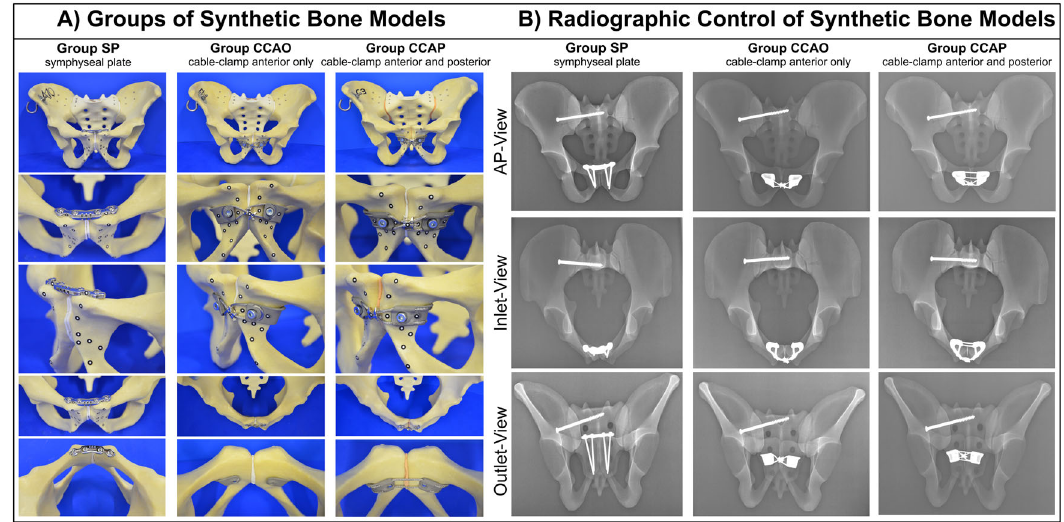
Fig. 2 Biomechanical test specimens. A Photographs of SP, CCAO, and CCAP devices attached to synthetic bone models used for biomechanical testing. The gold-standard four-hole SP served as a control. The CCAO device uses an extrapelvic cable, whereas the CCAP device uses a cable that enters the obturator foramen and surrounds the pubic symphysis. B X-ray images of SP, CCAO, and CCAP devices attached to synthetic bone models, shown from anterior – posterior (AP), inlet, and outlet views to con fi rm correct implant positioning.